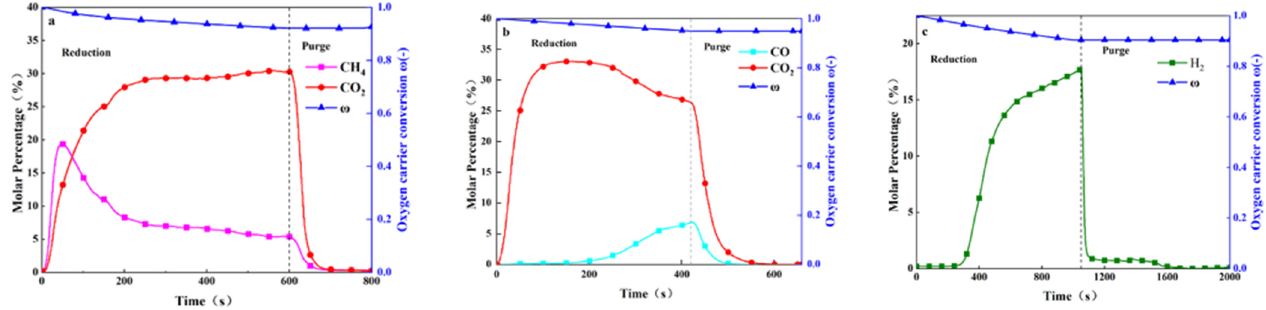
Figure 8. Typical reaction progress of the CA70-bonded oxygen carrier at 850 °C with ( a ) 20% CH 4 , 20% H 2 O, and 60% N 2 ; ( b ) 20% CO, 20% CO 2 , and 60% N 2 ; and ( c ) 20% H 2 , 50% H 2 O, and 30% N 2.